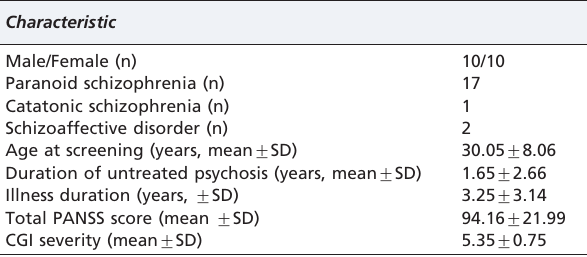
Table 1 - Patient baseline characteristics (n= 20).